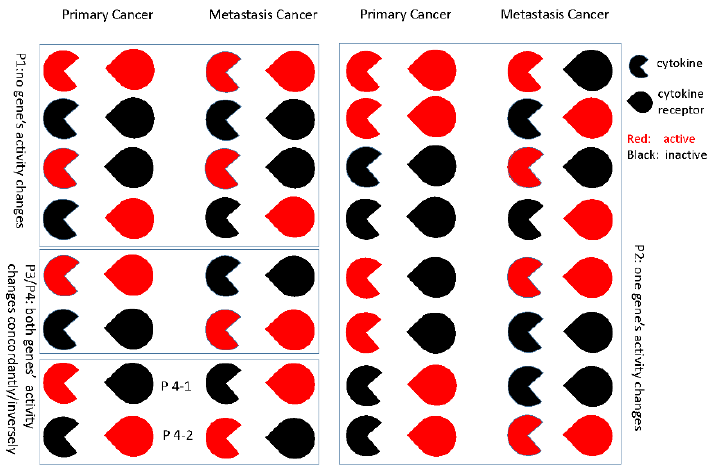
Figure 2. Gene-gene activity alteration patterns.